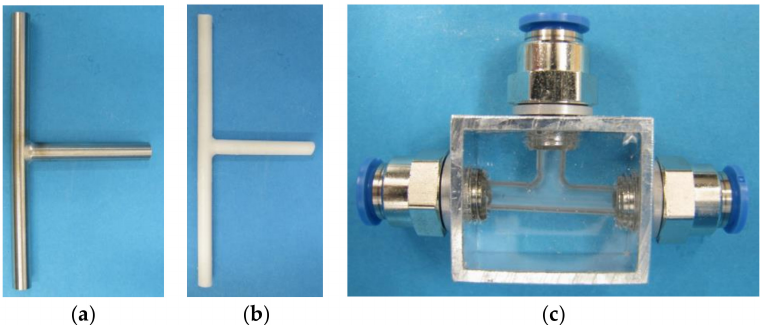
Figure 5. ( a ) Welded manifold with 90 ◦ angle; ( b ) silicone core made of Elastosil ® M 4601; ( c ) silicone replicate made of Elastosil ® RT 601 inside the aluminum frame with fluidic connections for µ -PIV